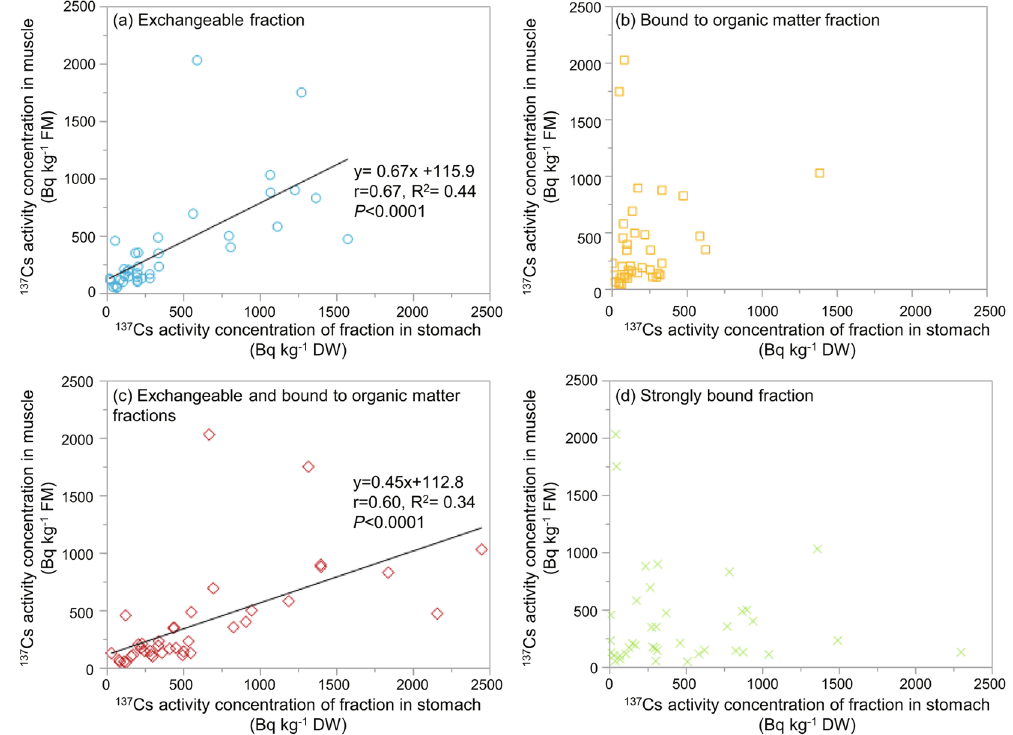
Figure 2. Relationship between the activity concentration of radiocaesium ( 137 Cs) in wild boar muscle tissue and in different fractions of stomach contents. The single regression line equation, adjusted R-square (R 2 ) and correlation coefficient (r) are shown only for the cases where a significant difference was observed between the two variables by regression and correlation analyses. DW: Dry weight, FM: Fresh